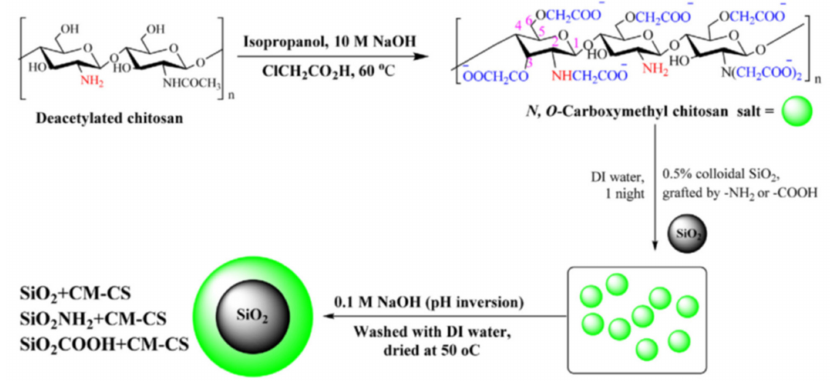
Figure 7. Synthesis of a core-shell composite based on carboxymethylchitosan (CM-CS) and silica particles (reprinted with permission from ref.